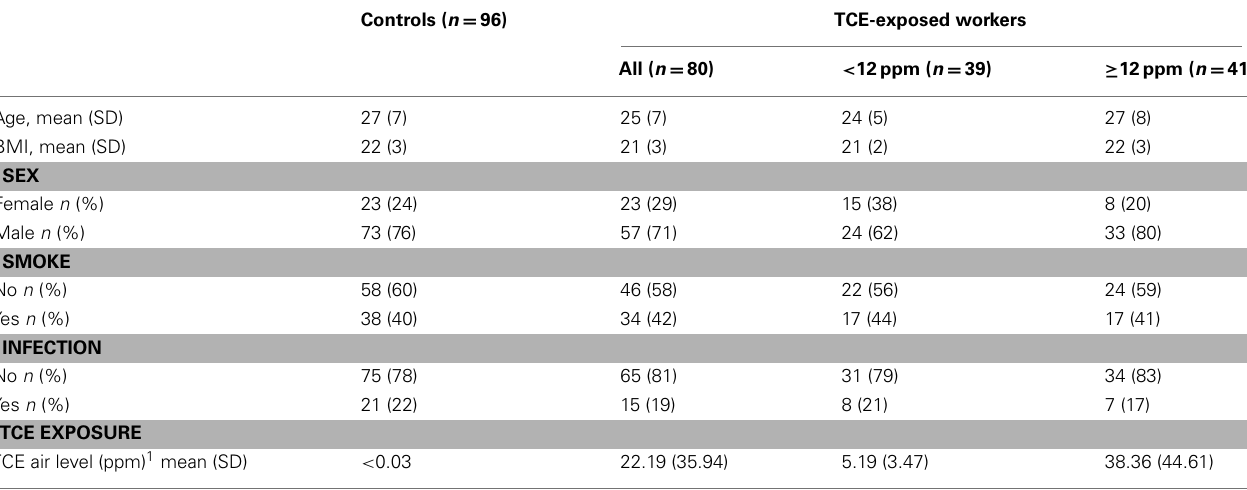
Table 1 | Demographic characteristics by trichloroethylene (TCE) exposure level of study subjects from Guangdong, China. Controls ( n = 96)